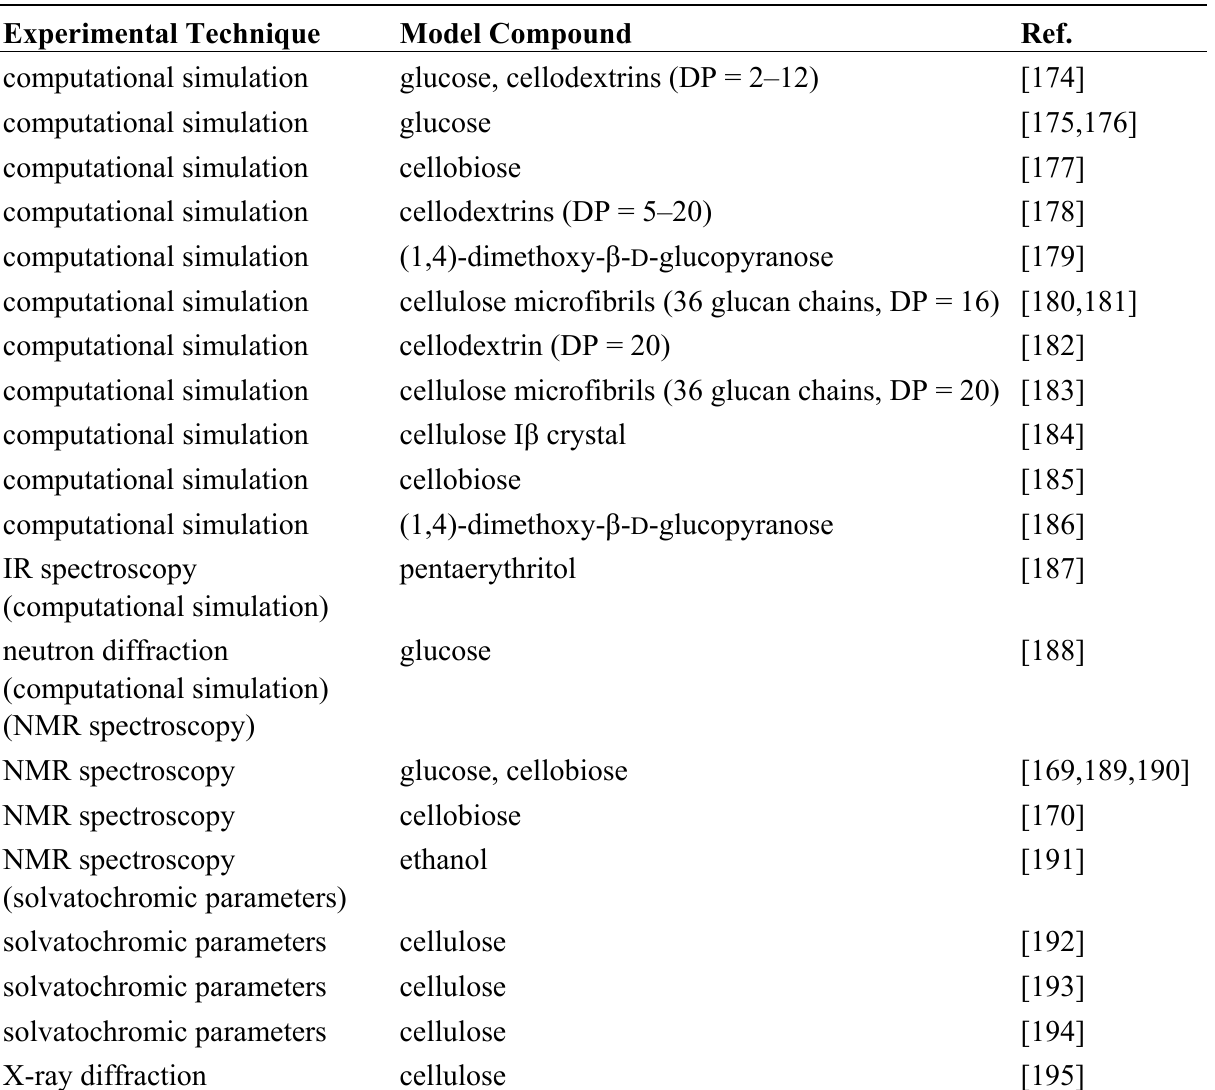
Table 3. Experiments performed to elucidate the mechanism of cellulose dissolution in ionic liquids. Experimental